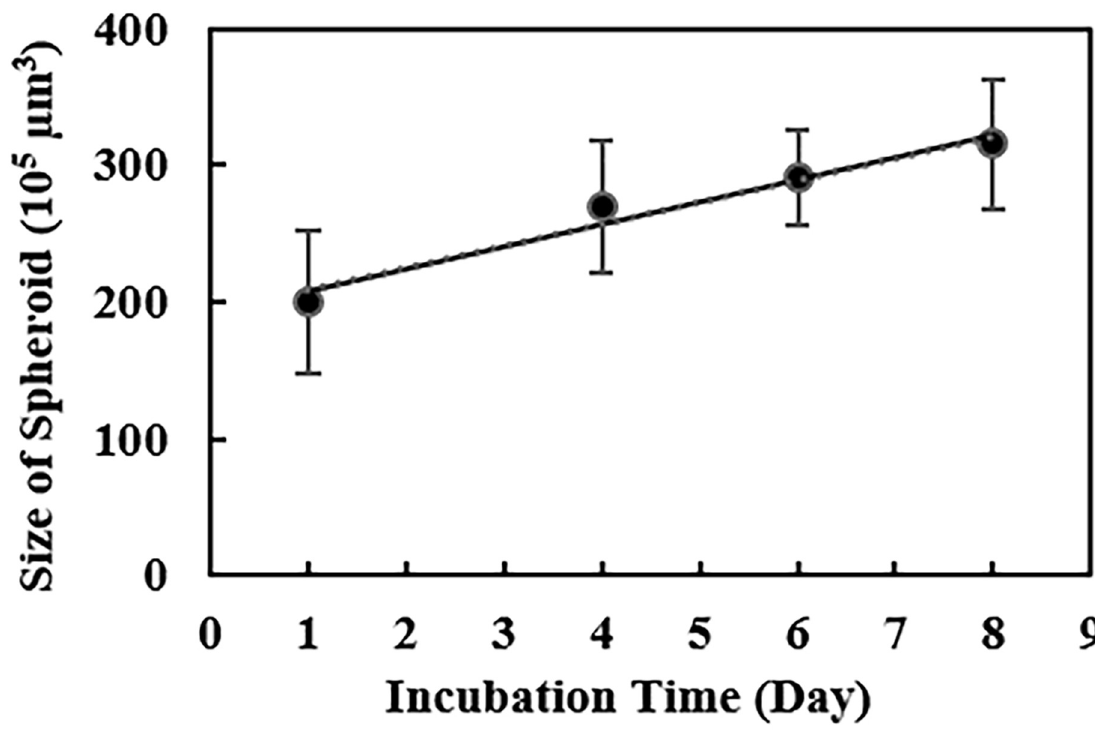
Fig 5. Growth rate of U251 spheroids in agarose microwells. Graph shows the measured volume of U251 spheroids as a function of time in 450 μ m-sized microwells (cell seeding densities of 6.0 × 10 5 cells/well). Data points represent the mean of 6 independent experiments and error bars show SD. Solid line shows the linear fit to data (y = 16.2x + 191.7, R 2 = 0.9610).